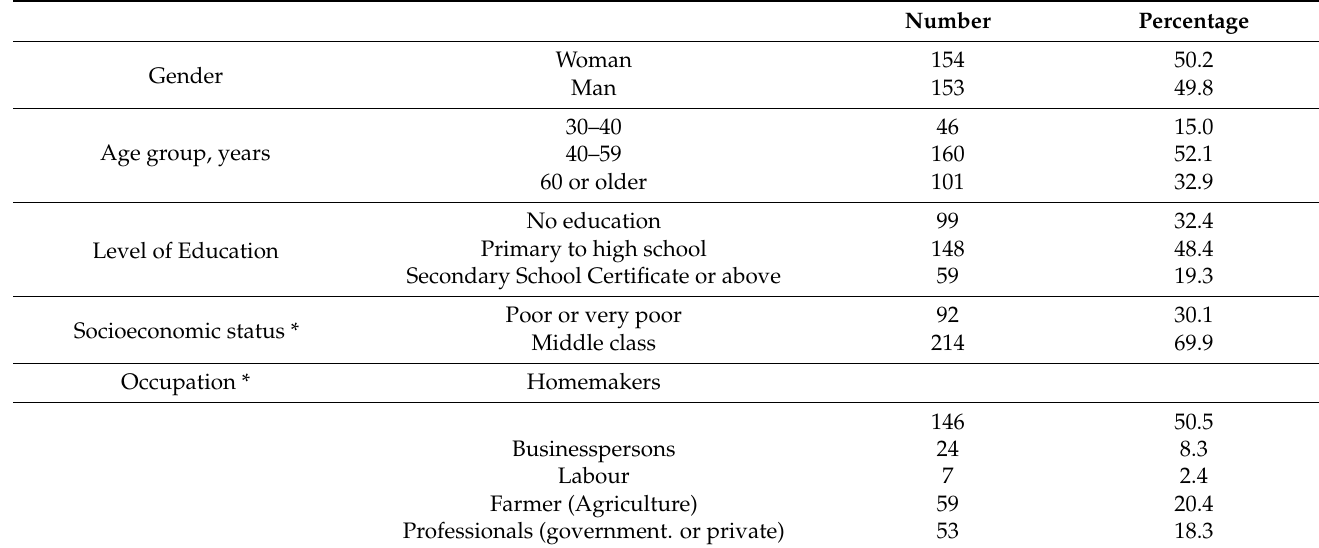
Table 1. Socio-demographic characteristics of the study